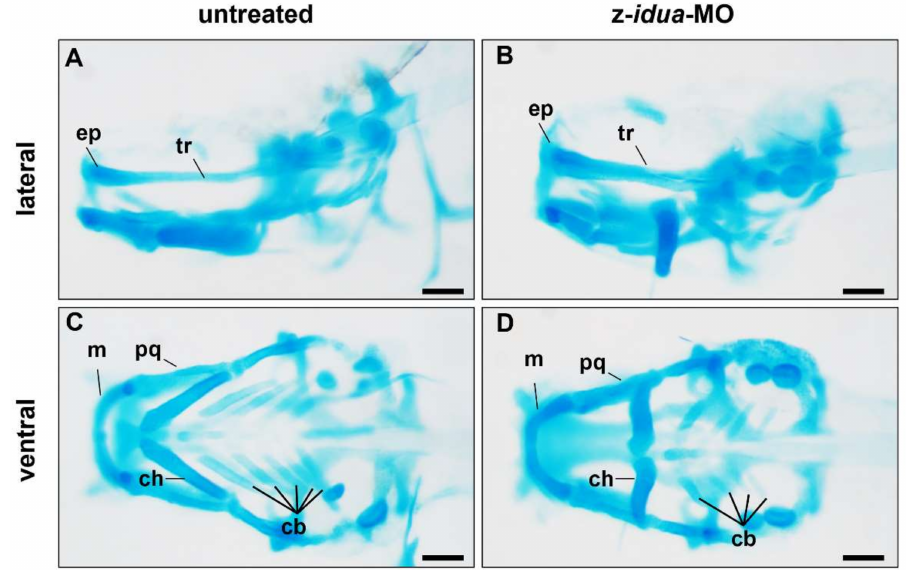
Figure 4. Knockdown of z- idua caused defective head cartilage in zebrafish embryos. Using alcian blue staining to detect the head cartilage of zebrafish embryos at 120 hpf. Untreated embryos (control) and embryos injected with antisense morpholino oligonucleotides (MO) complementary with z- idua (z- idua -MO) were studied. ( A , B ) Lateral view; ( C , D ) Ventral view; ( A , C ) Untreated control embryos; and ( B , D ) z- idua -MO injected embryos. Loss of function of z-Idua caused deformed cranial cartilage and decreased number of cartilage cells. cb, ceratobranchial; ch, ceratohyal; ep, ethmoid plate; m, Meckel’s cartilage; pq, palatoquadrate; tr, trabecular plate. Scale bar: 100 µ